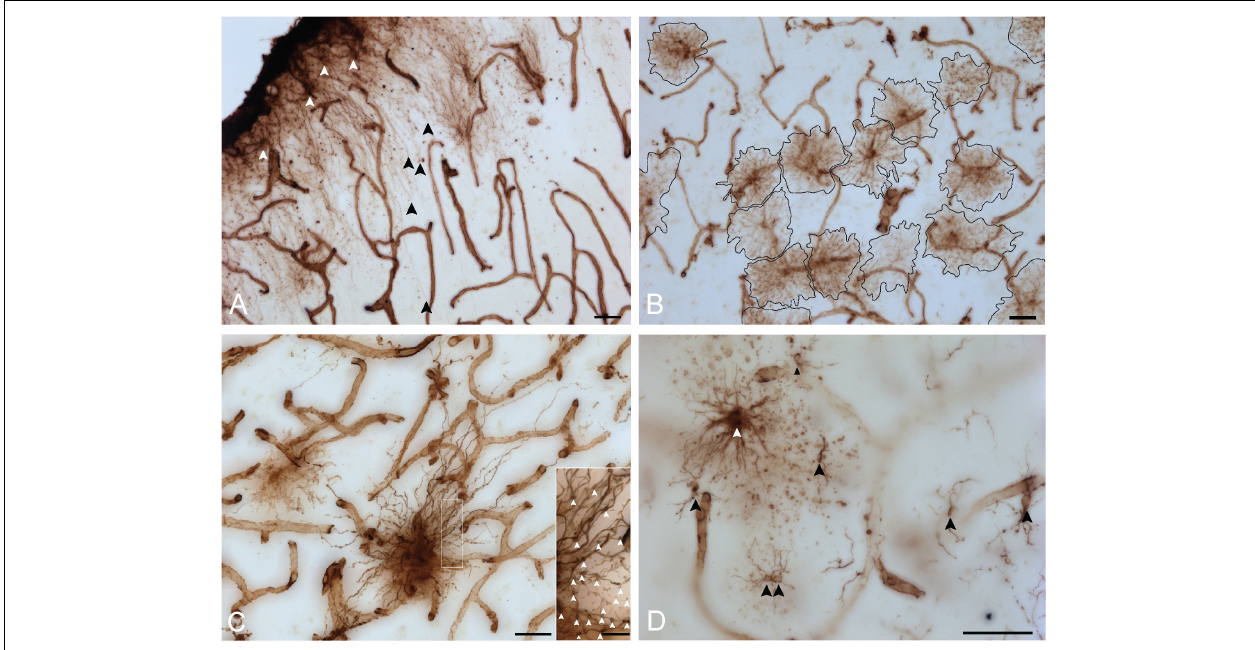
FIGURE 3 | VIM immunohistochemistry labels astrocytic subtypes previously described for GFAP-IR astrocytes in human neocortex. (A) Fine unbranched fibers (black arrowheads) emerging from darkly labeled VIM-IR interlaminar astrocytes (white arrowheads) and projecting to layer III. (B) VIM-IR astrocytes in the prefrontal cortex gray matter have a non-overlapping domain organization. (C) An example of a VIM-IR astrocyte in deep cortical gray matter (prefrontal cortex) with the attributes of a varicose projection astrocyte. The inset shows a magnified view of regularly spaced varicosities (arrows) on VIM-IR varicose projection astrocyte processes. (D) In cortical white matter and thalamus, VIM-IR astrocytes (white arrowhead) extended rather straight and mostly unbranched processes, as is typical for GFAP-IR fibrous astrocytes. VIM-IR microglia (black arrowheads) were also observed in cortical white matter. In general, these cells were weekly stained and easily distinguishable from VIM-IR astrocytes. Scale bars = 50 µ